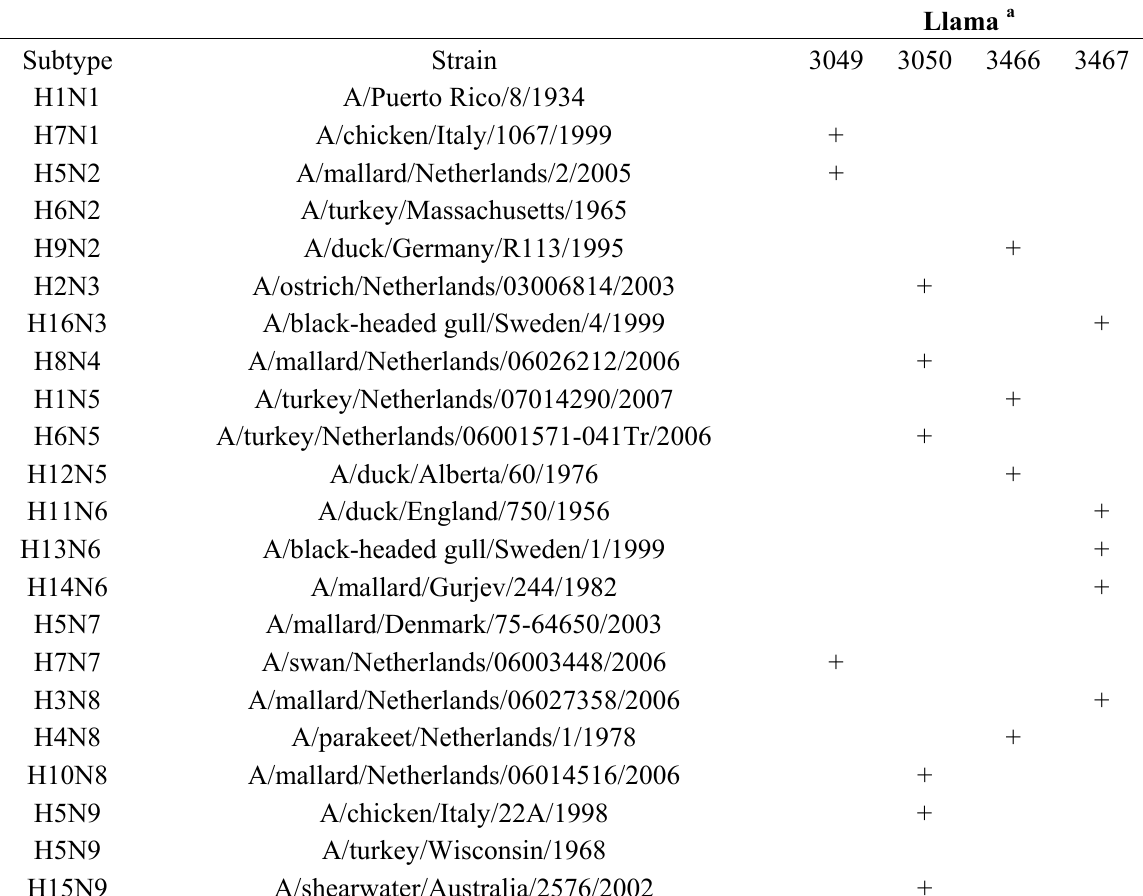
Table 8. Influenza A virus strains